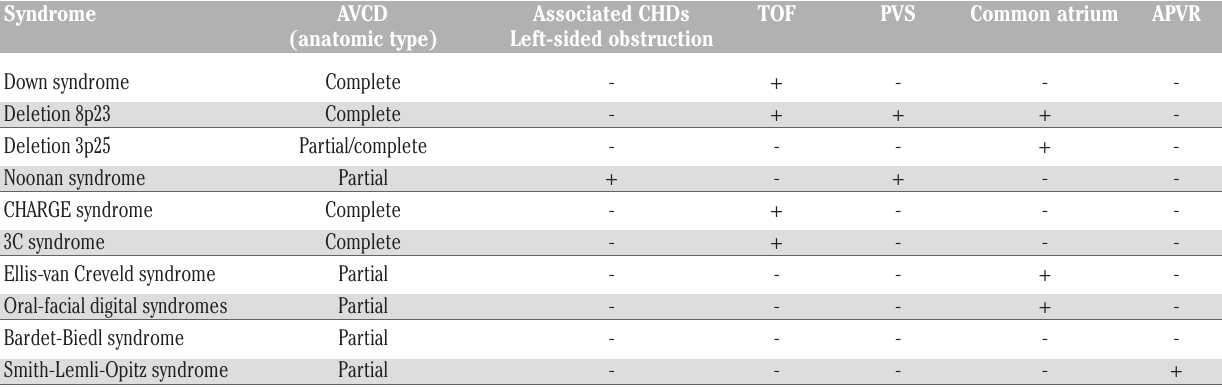
Table 2. Cardiac characteristics of genetic syndromes associated with atrioventricular canal